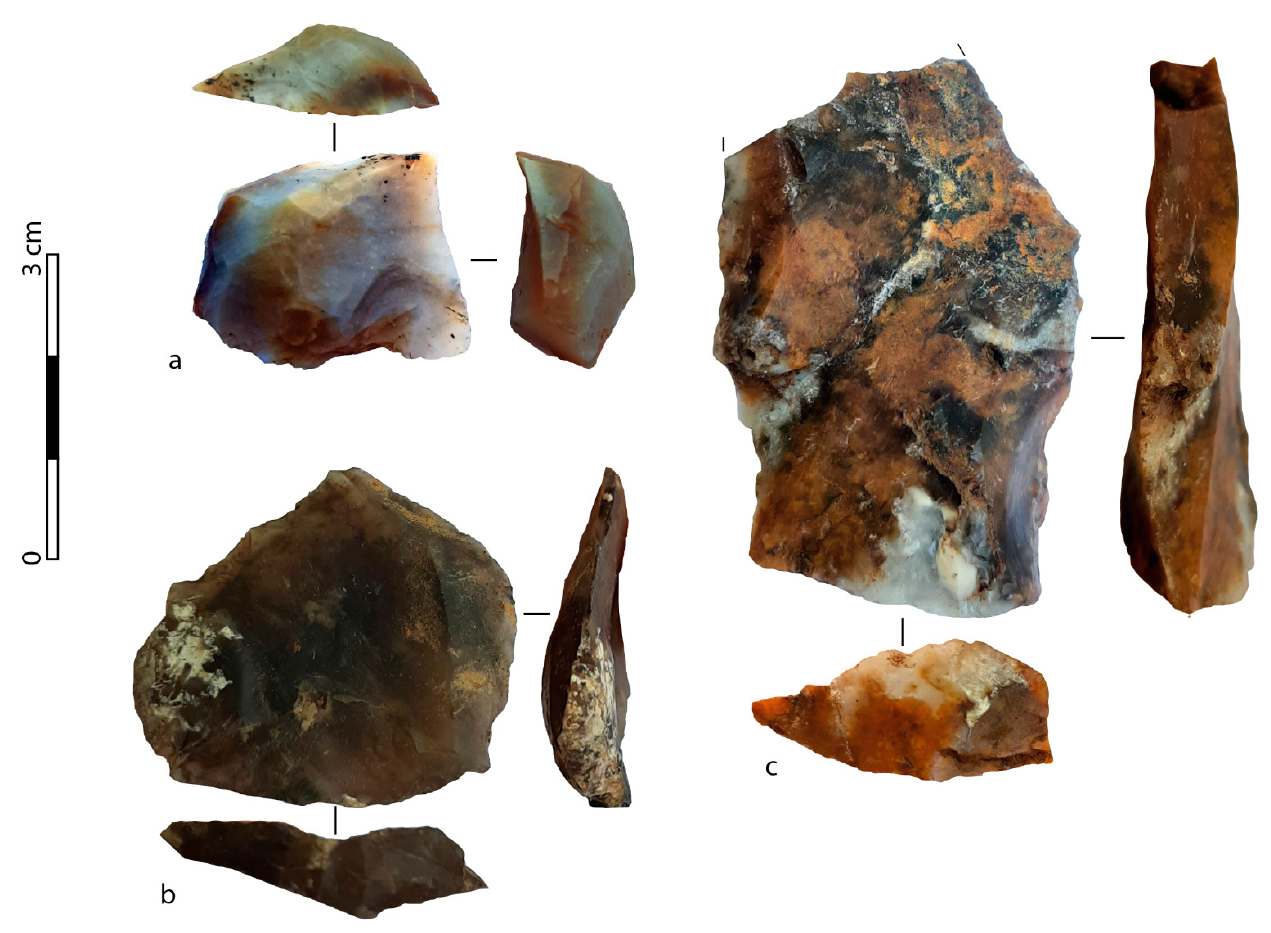
Figure 12. Lojanik 3, lithic artefacts from the Tri Stene Rockshelter: ( a ) carinated endscraper; ( b ) Levallois flake with facetted platform; ( c ) laminar blank.